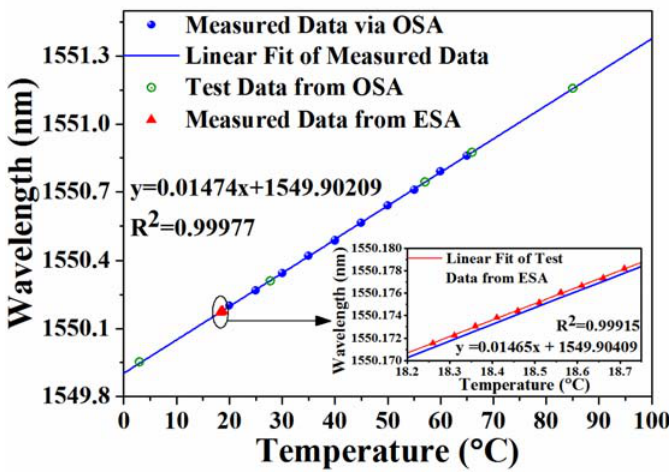
Figure 6. Relationship between the temperature and the wavelength of the single-frequency fiber laser.